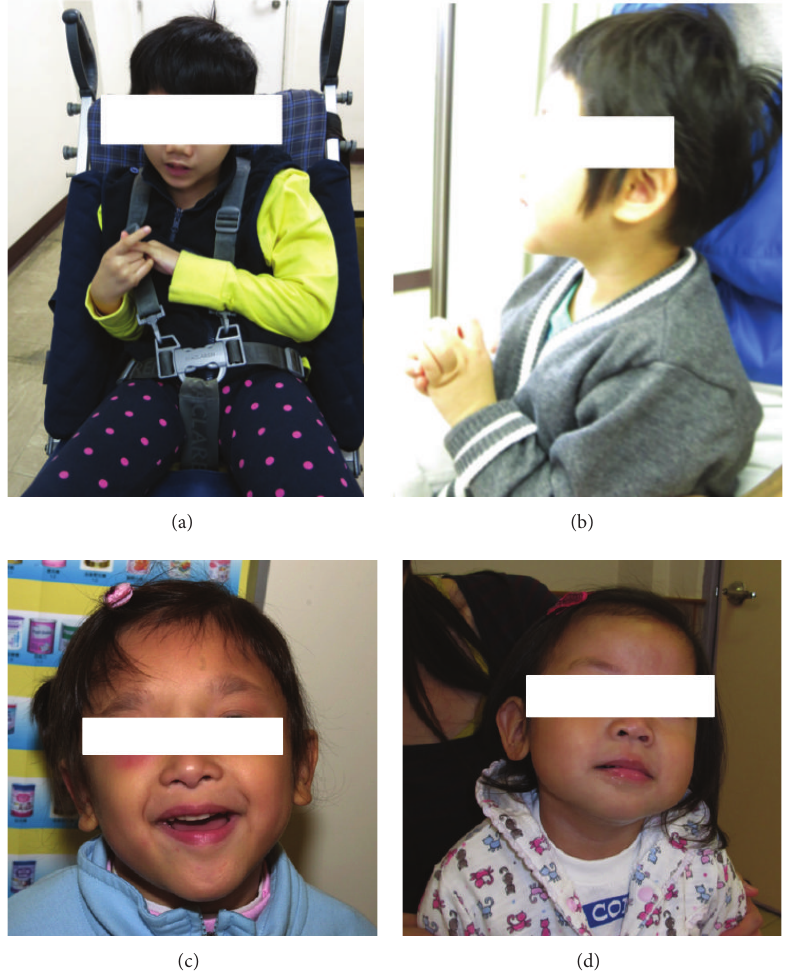
Figure 1: Facial features of different Angelman-like Syndromes in this series. (a) FOXG1 related disease; (b) Rett Syndrome. (c) Mowat-Wilson Syndrome; (d) Phelan-McDermid